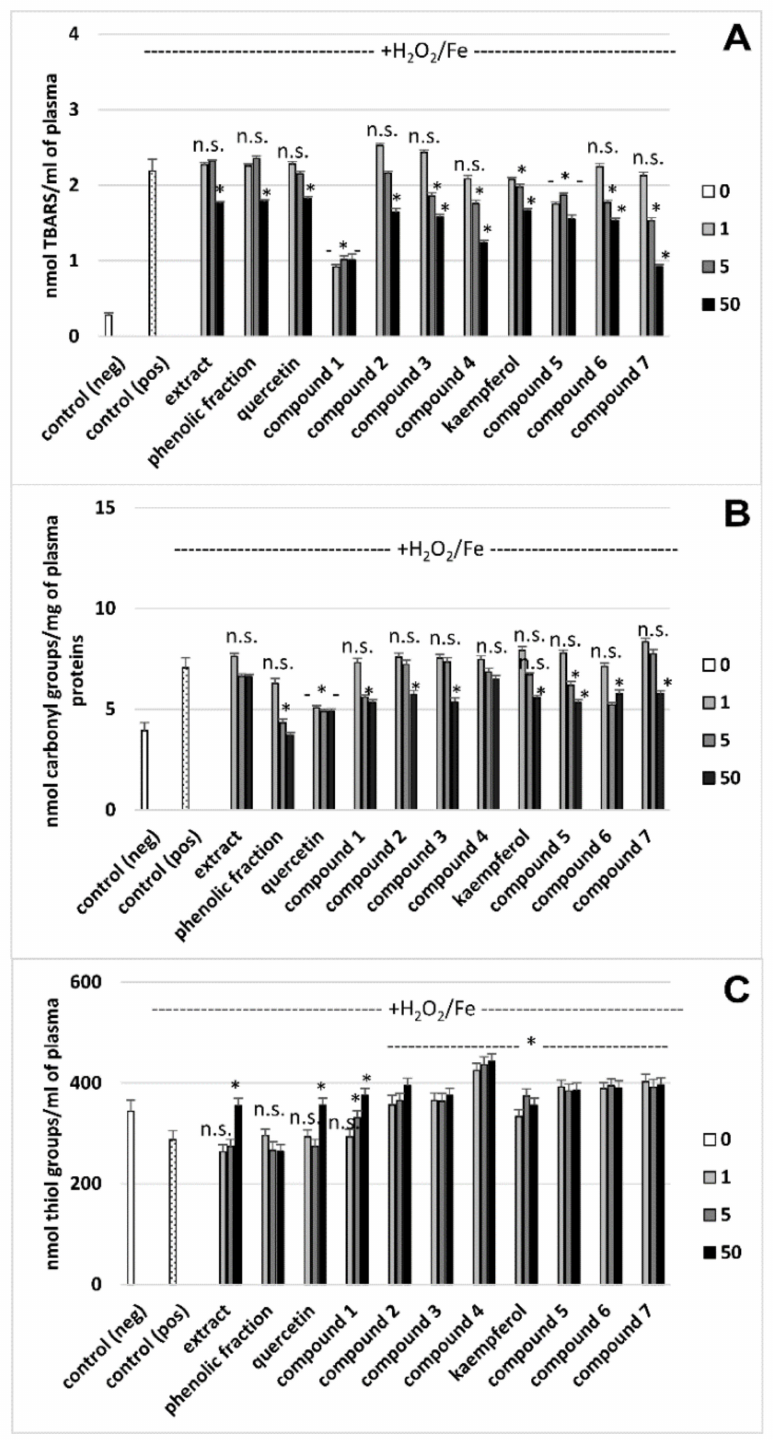
Figure 3. Effects of the crude extract, the phenolic fraction and flavonoids from lentil aerial parts (1–50 µ g/mL) and commercial flavonoids (quercetin and kaempferol) on plasma lipid peroxidation ( A ), plasma protein carbonylation ( B ), and oxidation of thiol groups ( C ), induced by H 2 O 2 /Fe. Control negative (neg) refers to plasma not treated with H 2 O 2 /Fe, whereas control positive (pos) to plasma treated with H 2 O 2 /Fe. Data represent means ± SD of 6 independent experiments. * p < 0.05 (vs. control (pos)), n.s. (statistically irrelevant) p > 0.05 (vs. control (pos)), p < 0.05 (between control (neg) and control (pos)); “-“ means the range of concentration of used